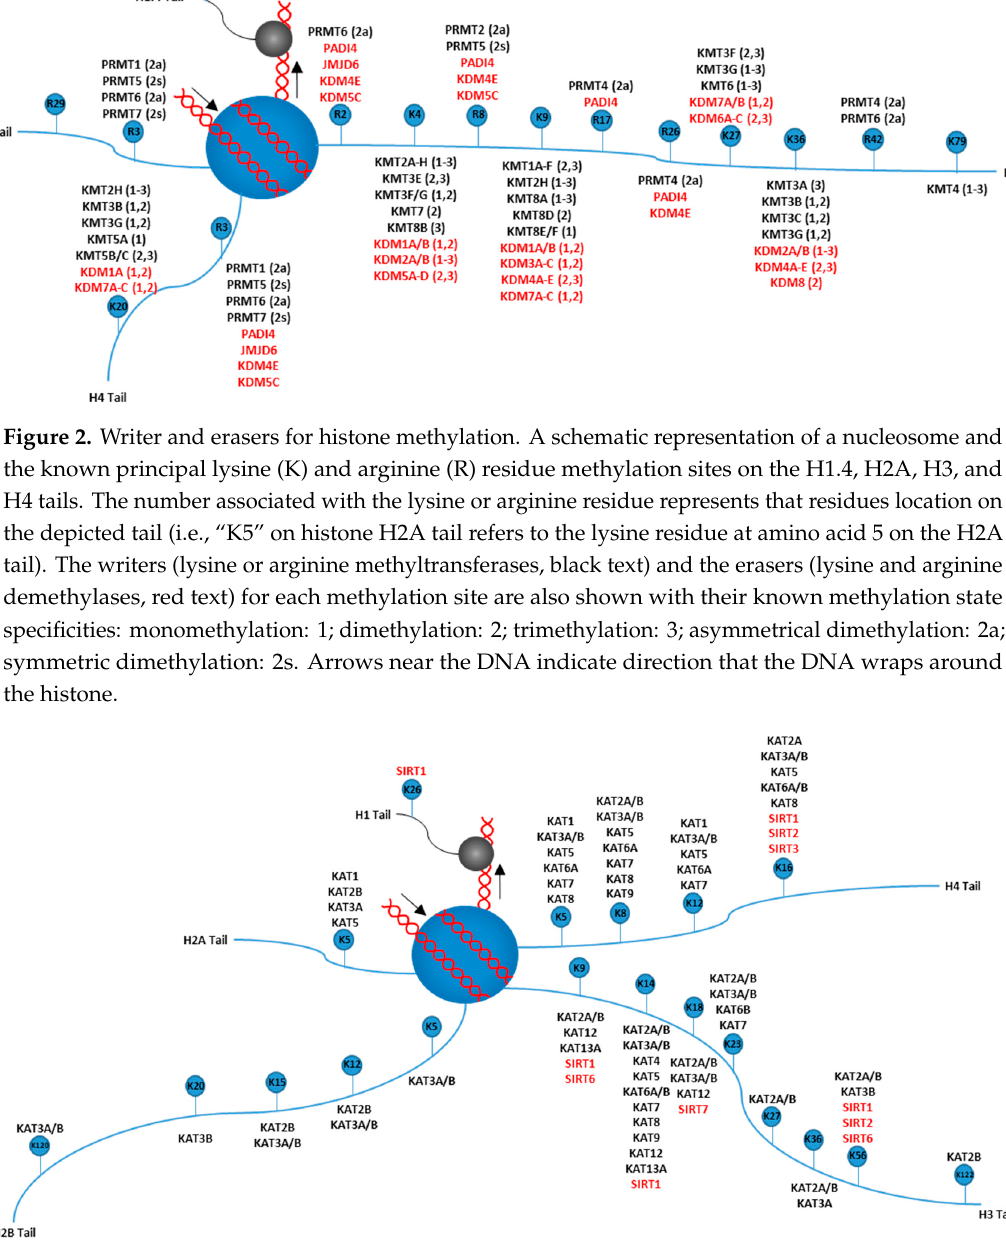
Figure 3. Writers and erasers for histone acetylation. A schematic representation of a nucleosome and the known principal lysine (K) acetylation residue sites on the H1, H2A, H2B, H3, and H4 tails. The number associated with the lysine residue represents that residues location on the depicted tail (i.e., “K5” on histone H2A tail refers to the lysine residue at amino acid 5 on the H2A tail). The writers (lysine acetyltransferases, black text) and the erasers (lysine deacetylases, red text) for each methylation site are also shown. Arrows near the DNA indicate direction that the DNA wraps around the histone.